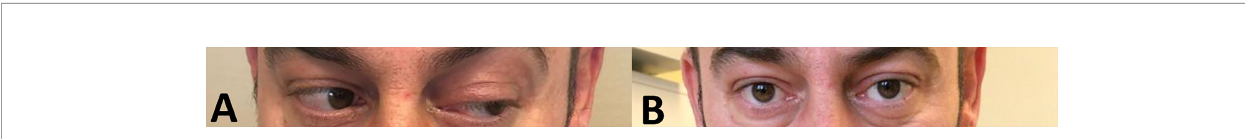
FIGURE 1 | (A) Preoperative photo showing left oculomotor palsy with partial ptosis and exaggerated abduction with downward deviation due to unopposed action of trochlear and abducens nerves. (B) Post-operative photo showing complete recovery of the left